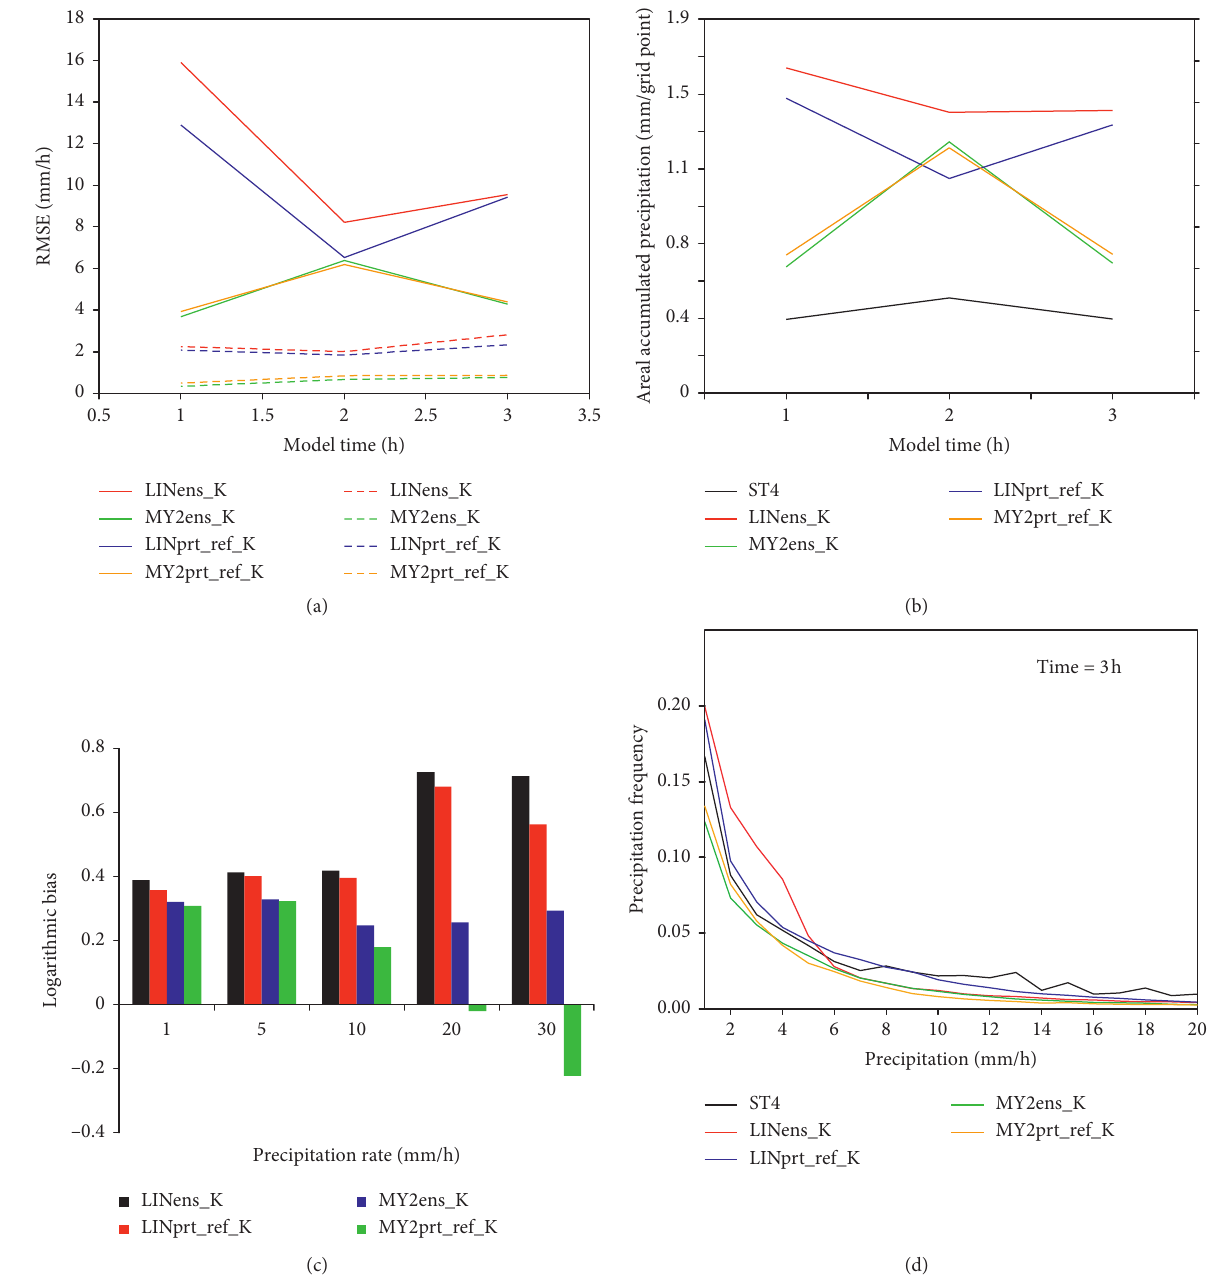
Figure 9: The same as in Figure 6, except for LINens_K, MY2ens_K, LINprt_ref, and